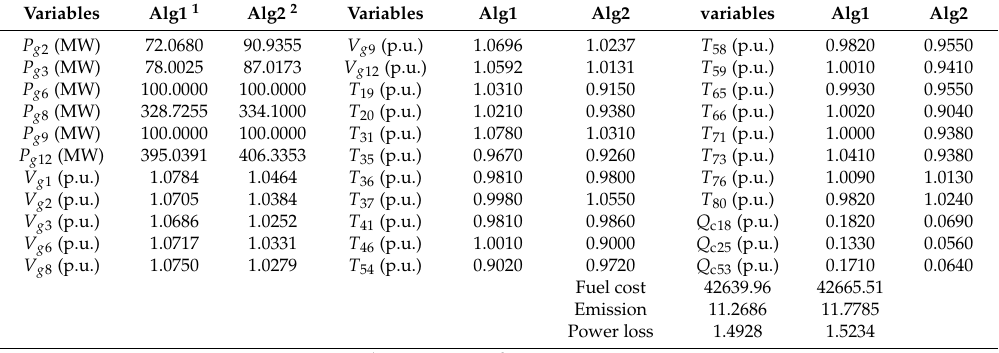
Table 8. Comparisons of the BCSs found by the MOFA-CPA and MOFA-PFA algorithms for Case 6. Variables